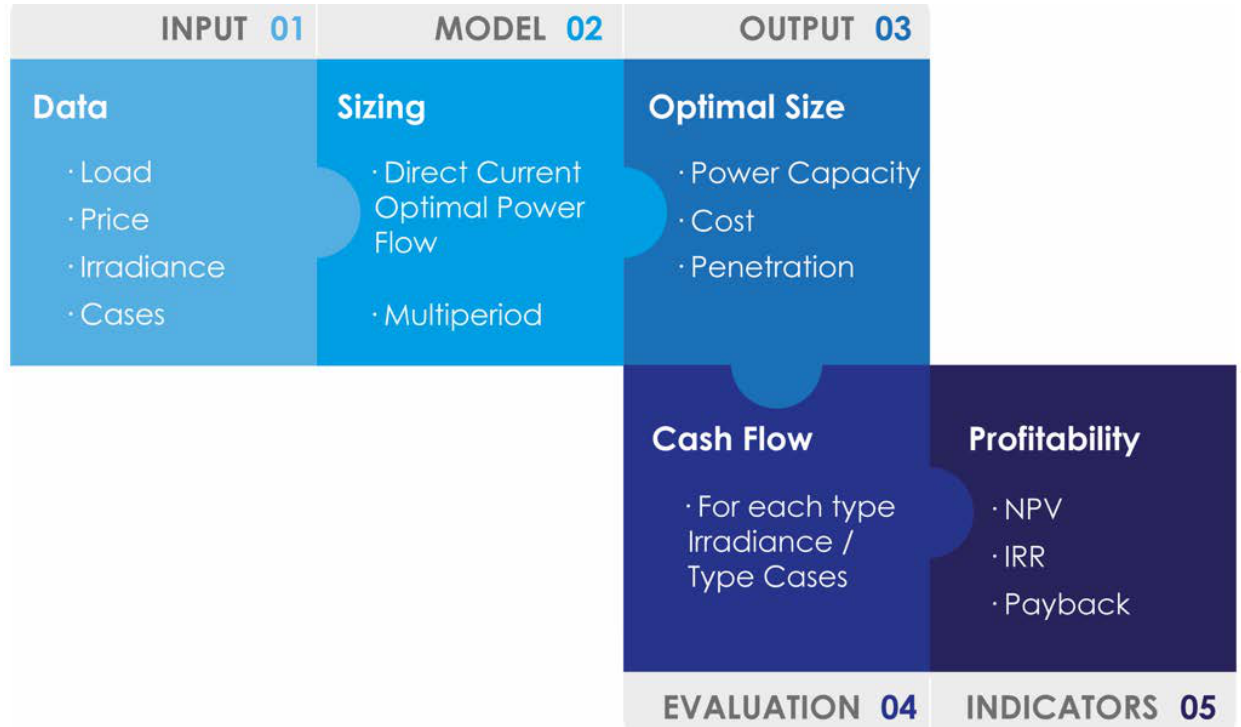
Figure 3. Average load per season.